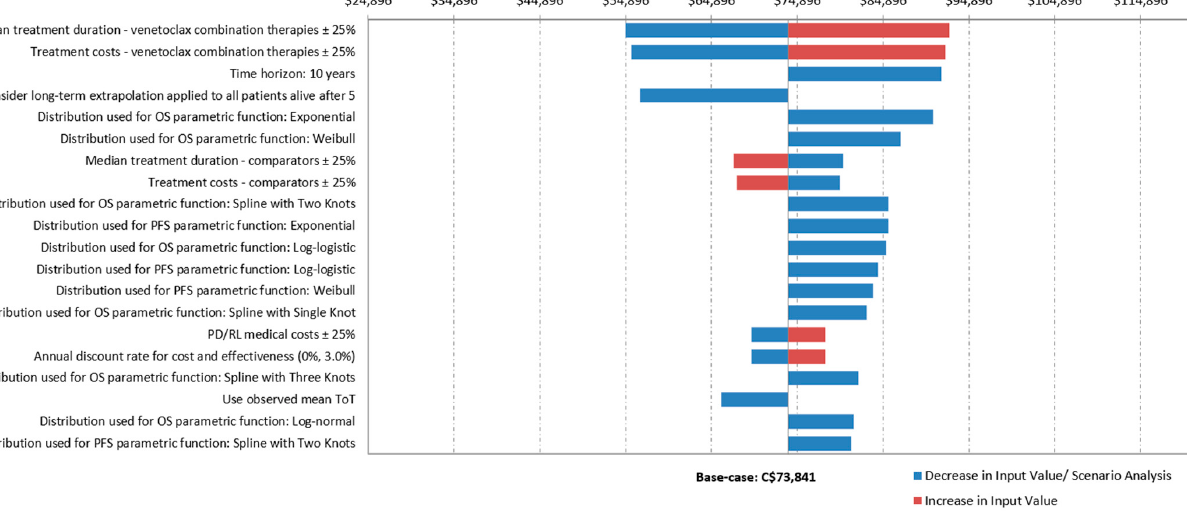
Figure 2. Results of one ‐ way sensitivity analyses from a Ministry of Health perspective. $CA: Cana ‐ dian